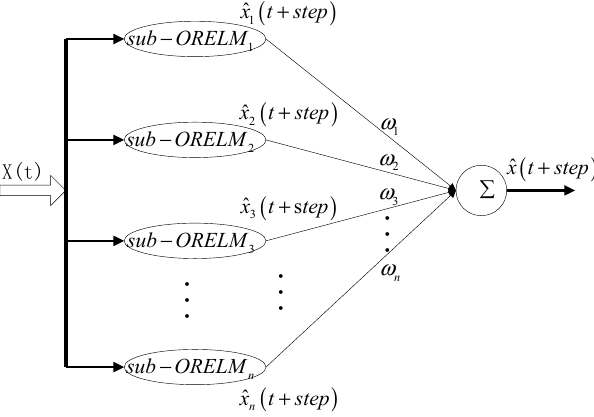
Figure 3. The structure of chaotic ensemble of OR-ELM (CE-ORELM).